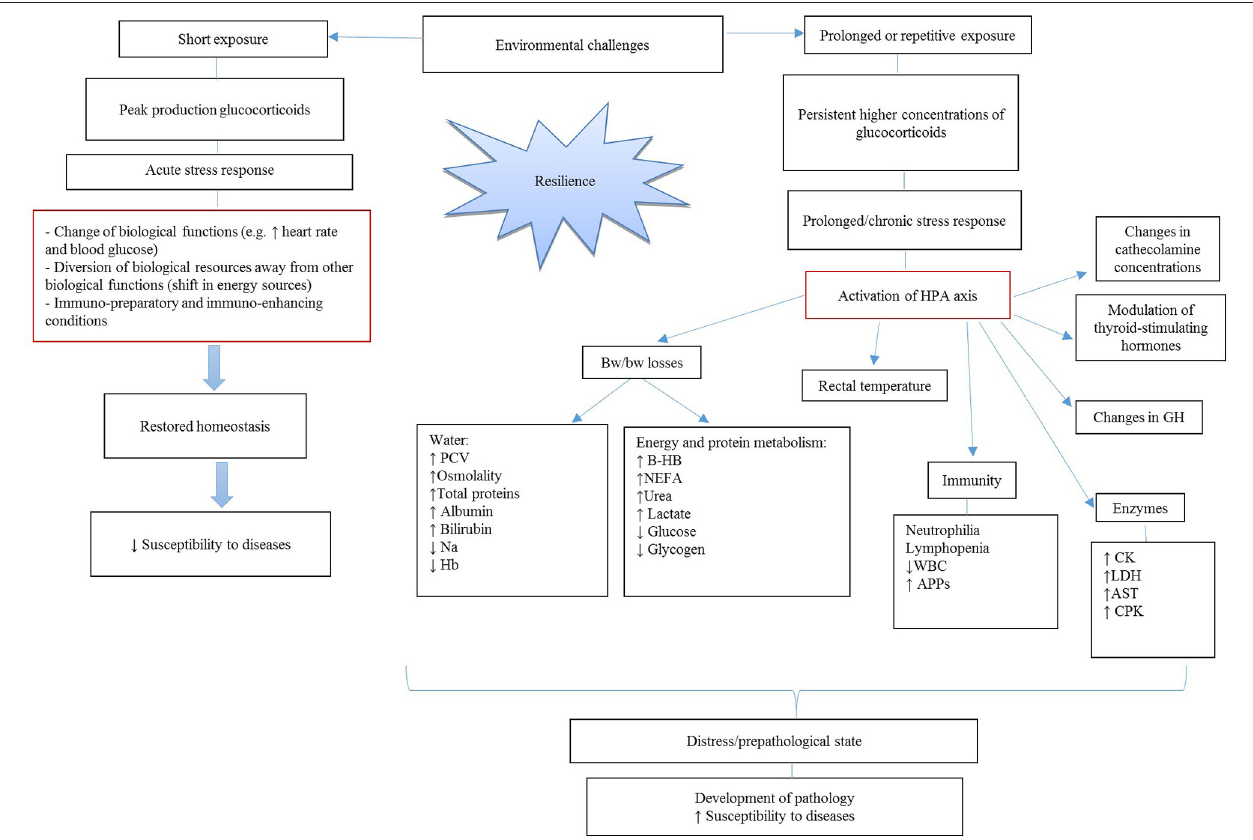
FIGURE 1 | Effects of short and long-term exposure to environmental challenges on disease susceptibility. HPA axis, hypothalamic-pituitary-adrenal axis; GH, growth hormone; BW, body weight; PCV, packed cell volume; Hb, hemoglobin; β -HB, β - hydroxybutyrate; NEFA, non-esterified fatty acids; WBC, white blood cells; APPs, acute phase proteins; CK, creatine kinase; LDH, lactate dehydrogenase; AST, aspartate aminotransferase; CPK, creatine phosphokinase.